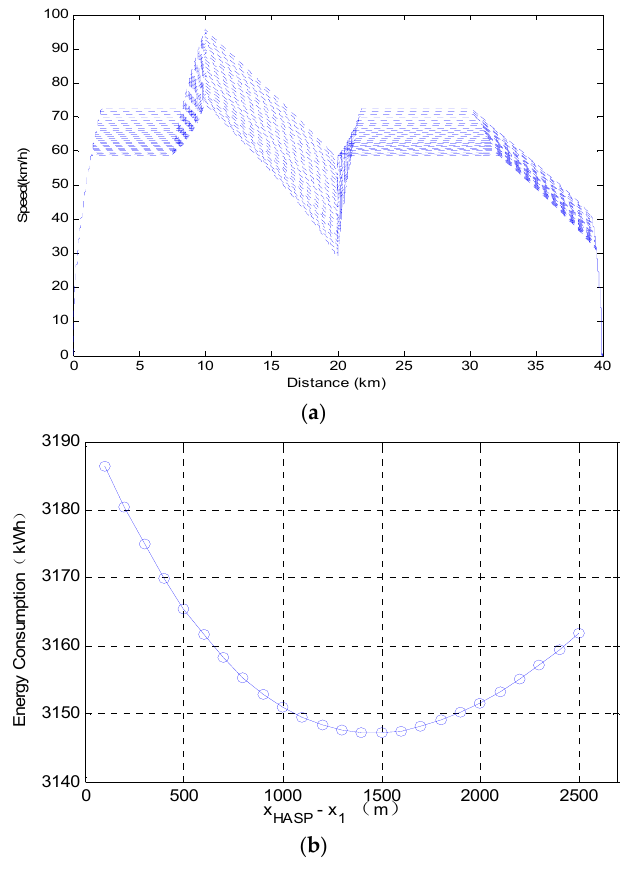
Figure 15. Comparison chart of different steep ‐ uphill ‐ pass strategies on a 10 km uphill slope. ( a ) Speed profiles of different strategies; ( b ) Energy consumptions of different strategies in ( a ).